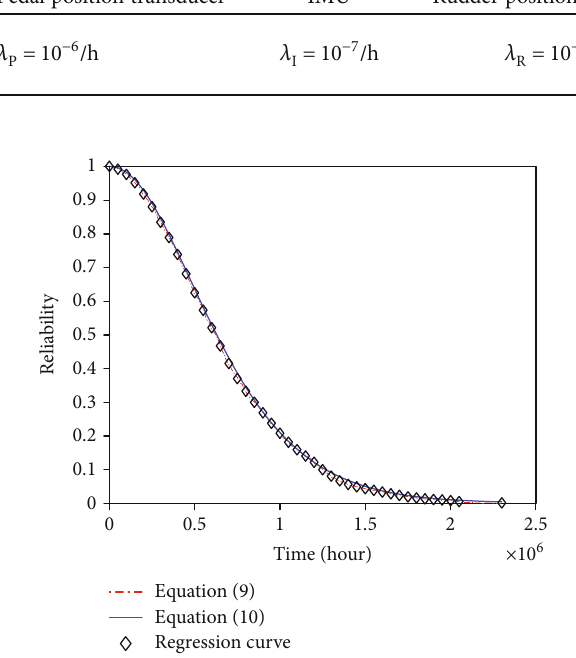
Figure 14: The reliability curves obtained by di ff erent